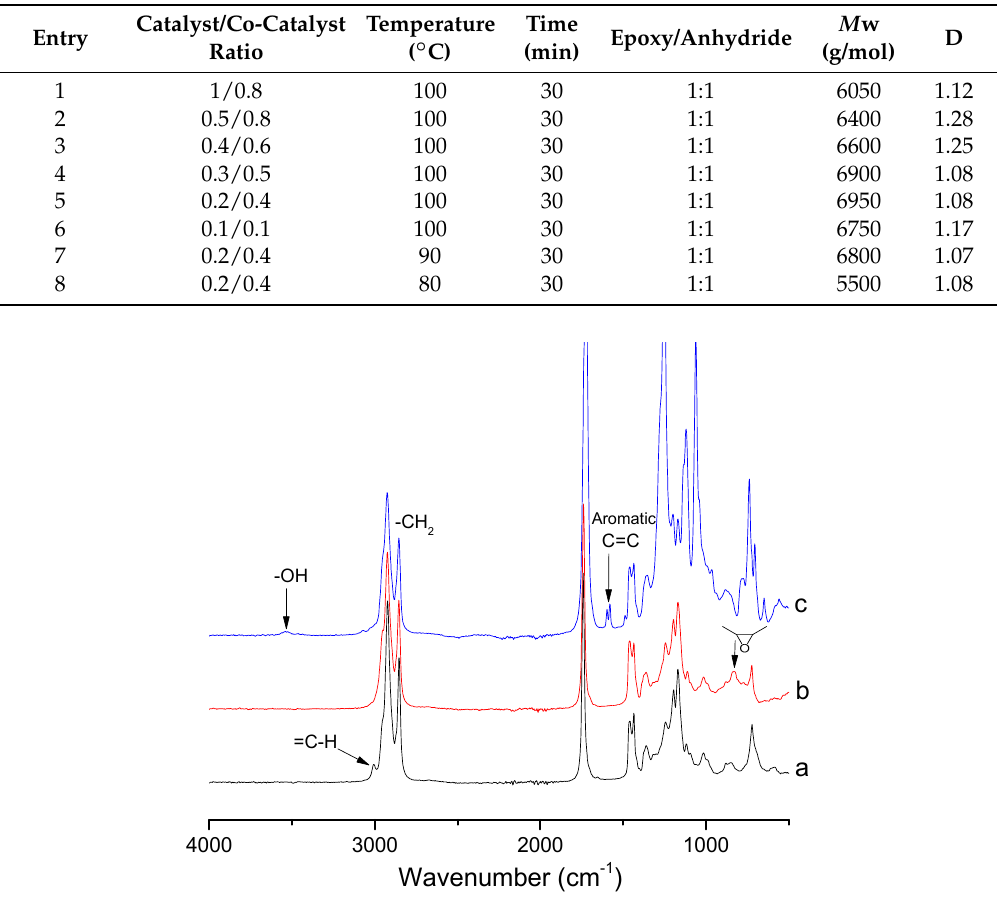
Table 2. Co-polymerization of epoxide and phthalic anhydride using (salen)Cr III Cl as catalyst and DMAP as co-catalyst.